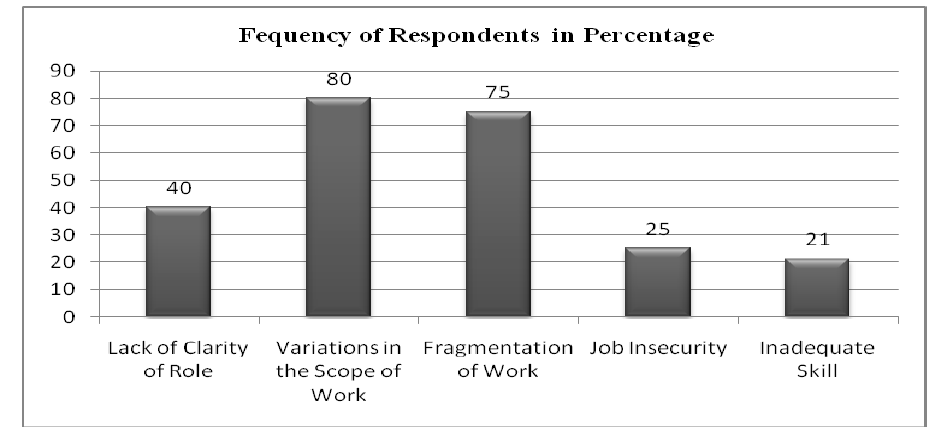
Figure 3 Job role stress factors (Source: Field survey, 2008)